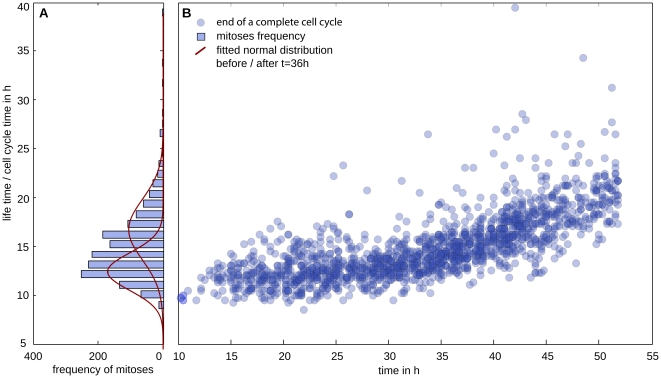
Life time distribution.(A) displays the histogram data of the life time distribution (time between consecutive mitoses) and a fitted normal distribution for all path lengths before and after t = 36 h (onset of contact inhibition, cf. figs 10 & 11); (B) illustrates the prolongation and distribution of the life time when reaching confluency.